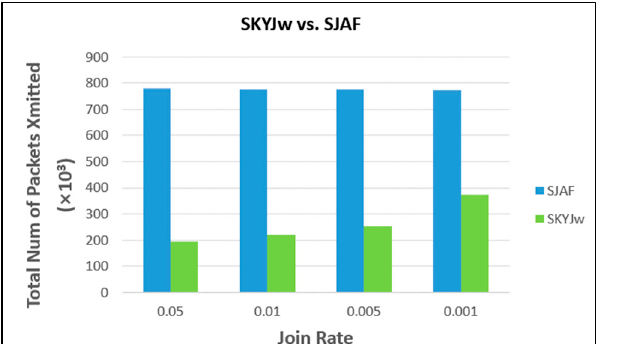
Figure 15. ( a ) Comparison between SKYJw and SJAF as the join rate varies from 0.5 to 0.001. ( b ) The cost for finding the anchor points and that of tuple transmission as the join rate varies as in ( a ).